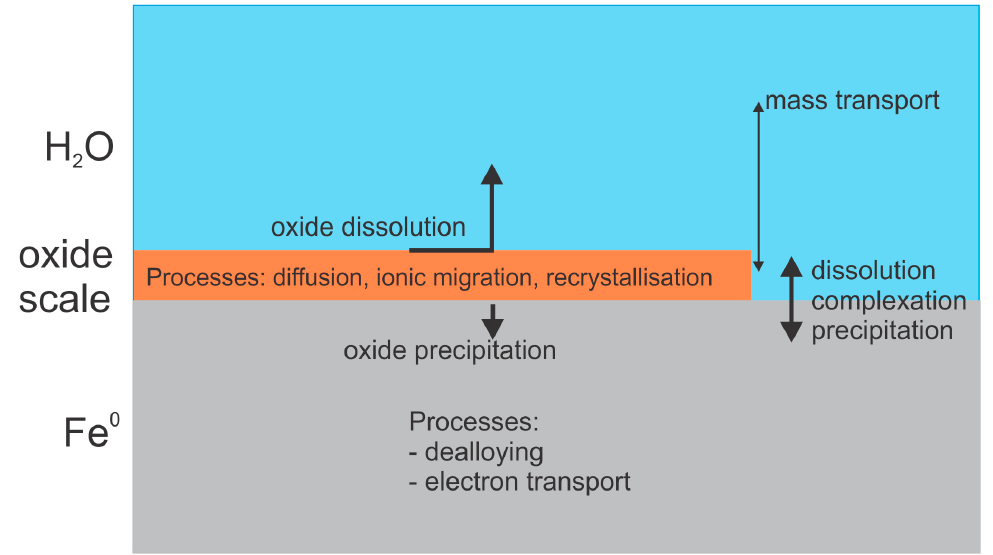
Figure 1. Schematic of the elemental iron (Fe 0 )/H 2 O system. Features relevant to contaminant removal are labelled. Modified after Taylor [91].